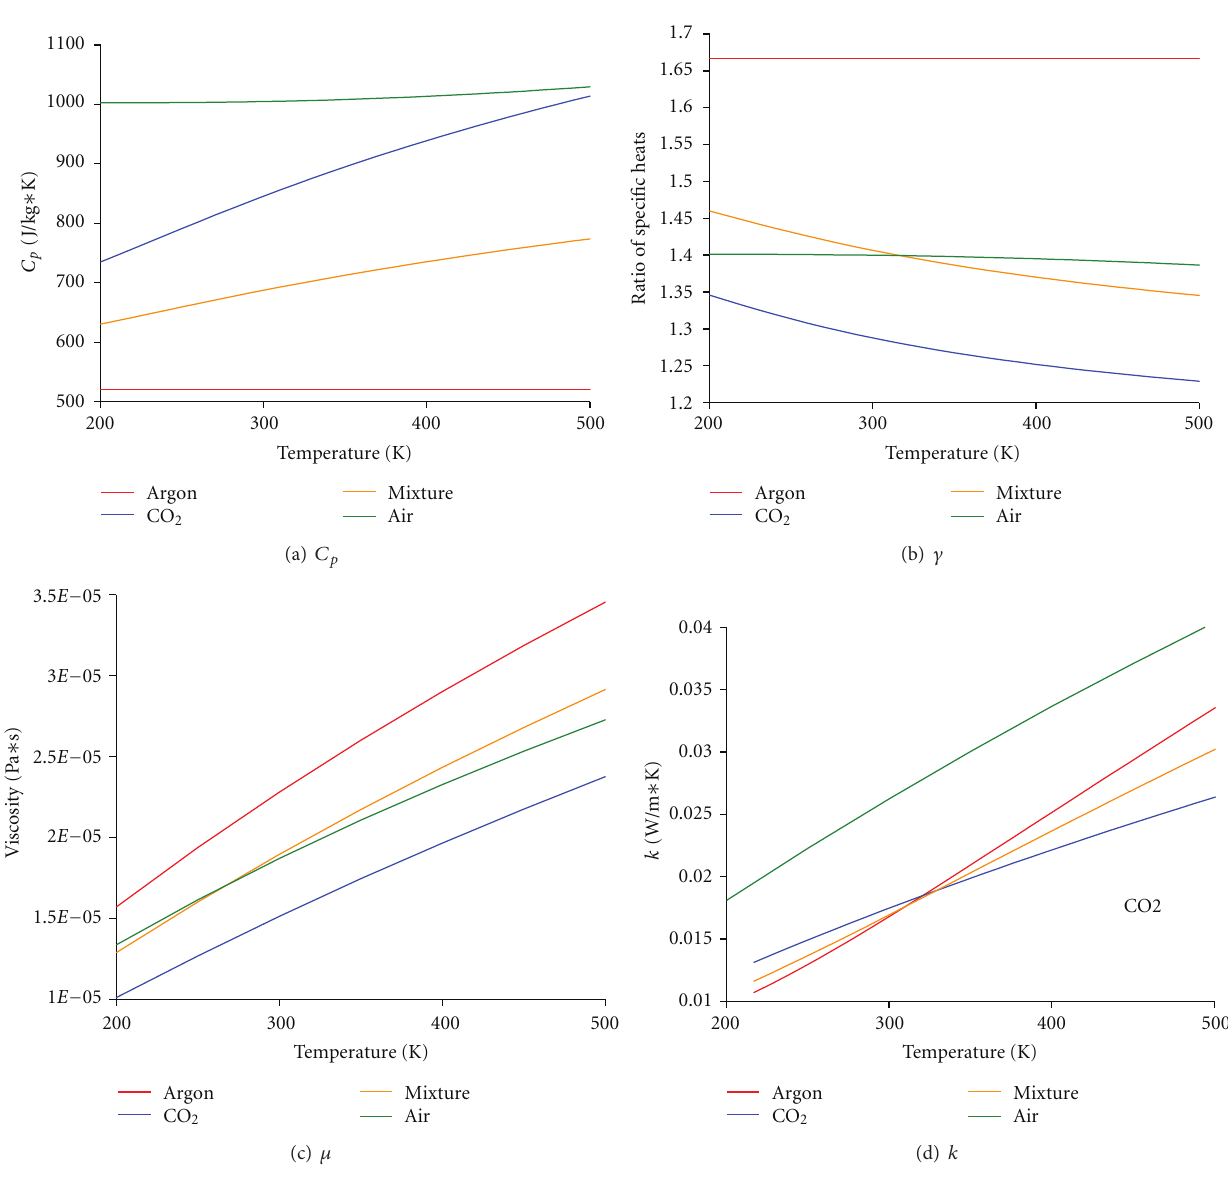
𝑘𝑘 F 8: Gas properties for air, CO